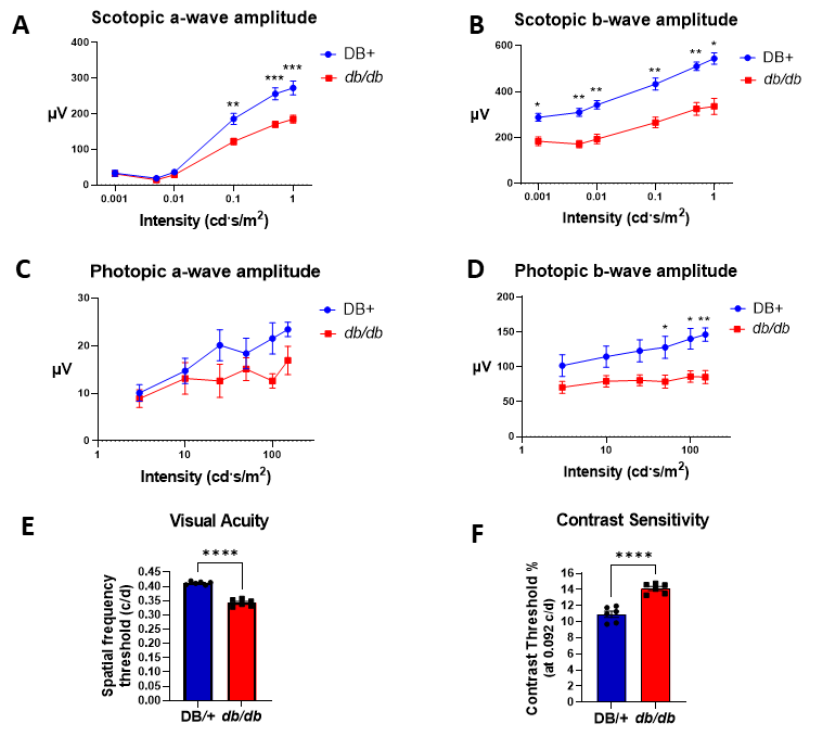
Figure 1. The db/db mice showed impaired retinal and visual function. ( A , B ) Scotopic electroretinography (ERG) responses and ( C , D ) photopic ERG responses were recorded in female db/db mice and lean DB/+ controls. Mice were dark-adapted overnight prior to the scotopic ERG response assessment. For photopic measurements, mice were exposed to a bright probe light for 5 min to saturate rod signals. Mean amplitudes of the scotopic and photopic a- and b-wave ERG components ( A , C and B , D , respectively) with the SEM of flash responses are plotted against the luminance intensity (cd · s/m 2 ). ( E ) The spatial frequency threshold (a measure of visual acuity) was significantly reduced in db/db mice compared with the lean controls. ( F ) The contrast threshold (the measure of minimum level of contrast that could be discerned by the mouse) was significantly impaired in the db/db mice compared with the lean controls. Data are presented as the mean ± SEM. * p < 0.05, ** p < 0.01, *** p < 0.001, **** p <